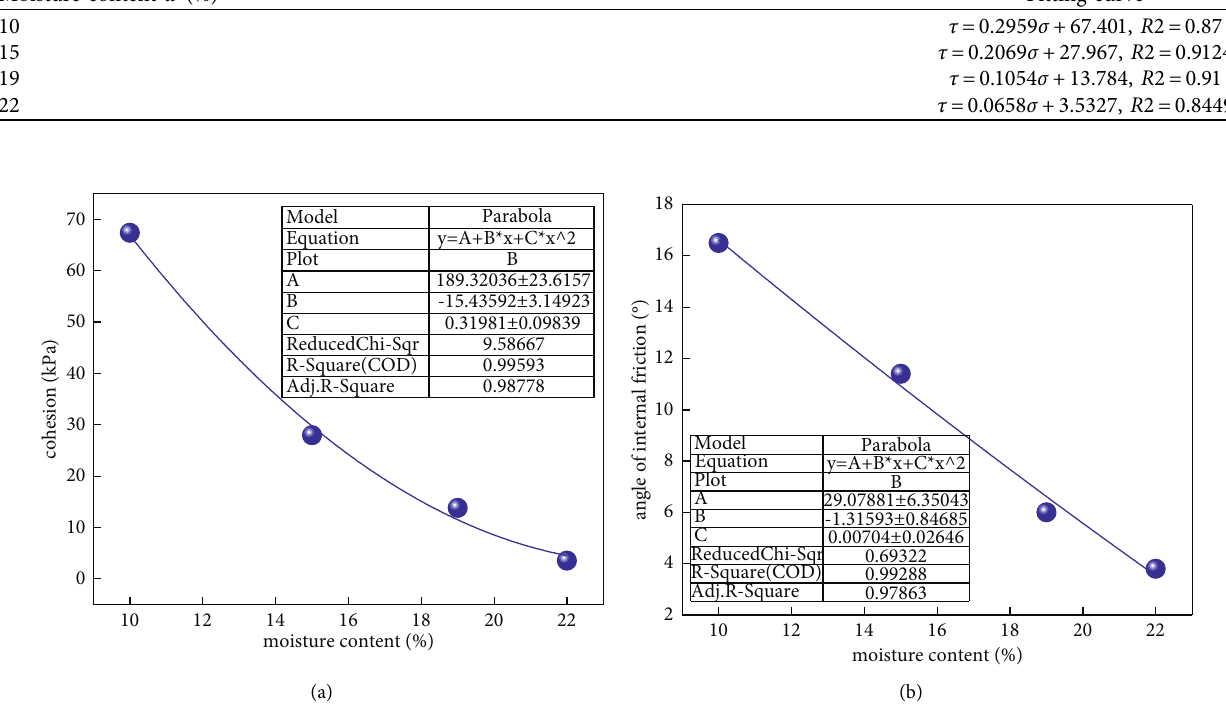
Table 8: Fitting lines of the relationship between shear strength and normal pressure under different moisture contents. Moisture content ω (%) Fitting curve